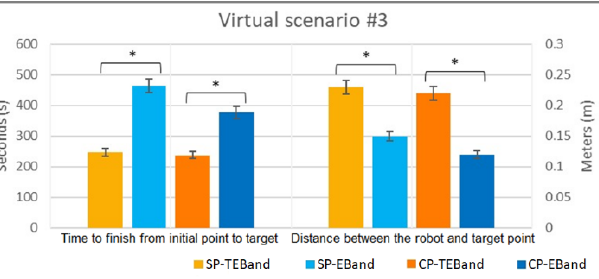
Figure 17. Comparison of time taken to finish and error among experimental groups in the indus- trial manufacturing scenario (* p < 0.05).